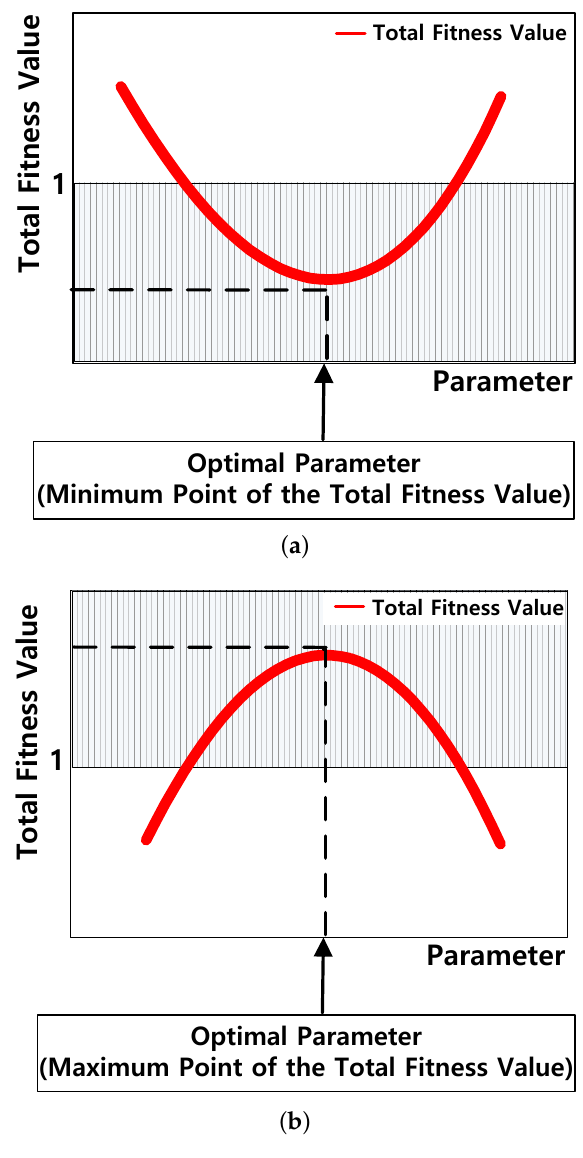
Figure 8. The concept of the penalty method. ( a ) The optimal parameter at the minimum point; ( b ) the optimal parameter at the maximum